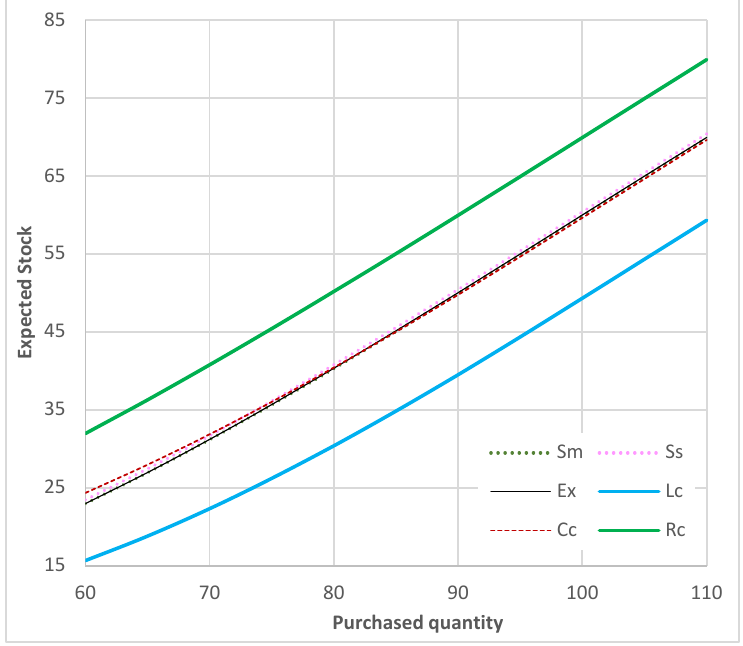
Fig. 10. Simulated stock-consumption trends, for X = 70, q = 80 ad T